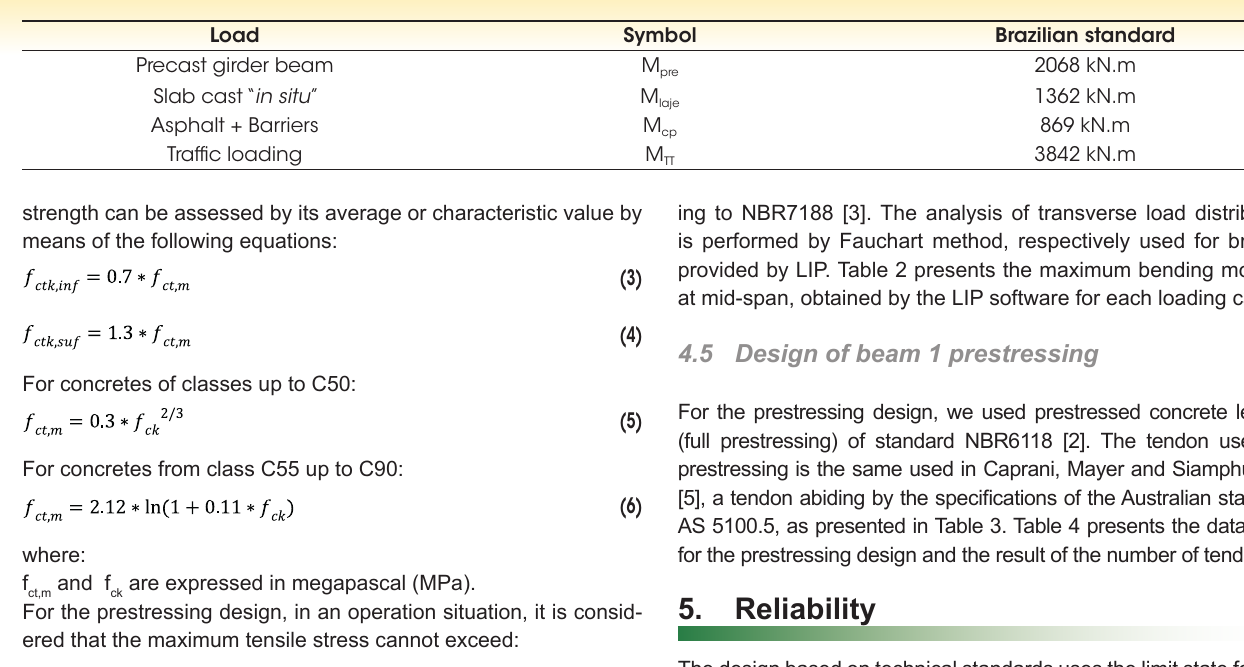
Beam 1 maximum bending moments for different load components